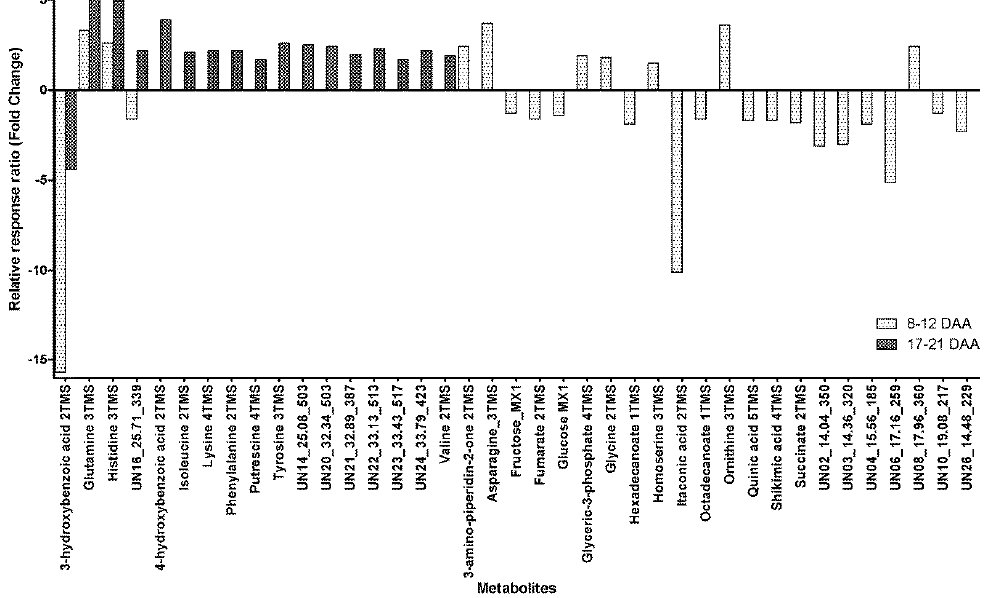
Figure 2. Fold change from before 14:00 to after 14:00 for metabolites in the phloem exudate metabolite profile with significant within-day variability in relative response ratios when collected at different maturities (8–12 DAA and/or 17–21 DAA) (DAA, days after anthesis; xTMS, Trimethylsilyl derivative where x is the number of TMS groups; yMX, methoxyamine derivatized product where y = 1 or 2; Table S4 presents the values for the relative response ratios).